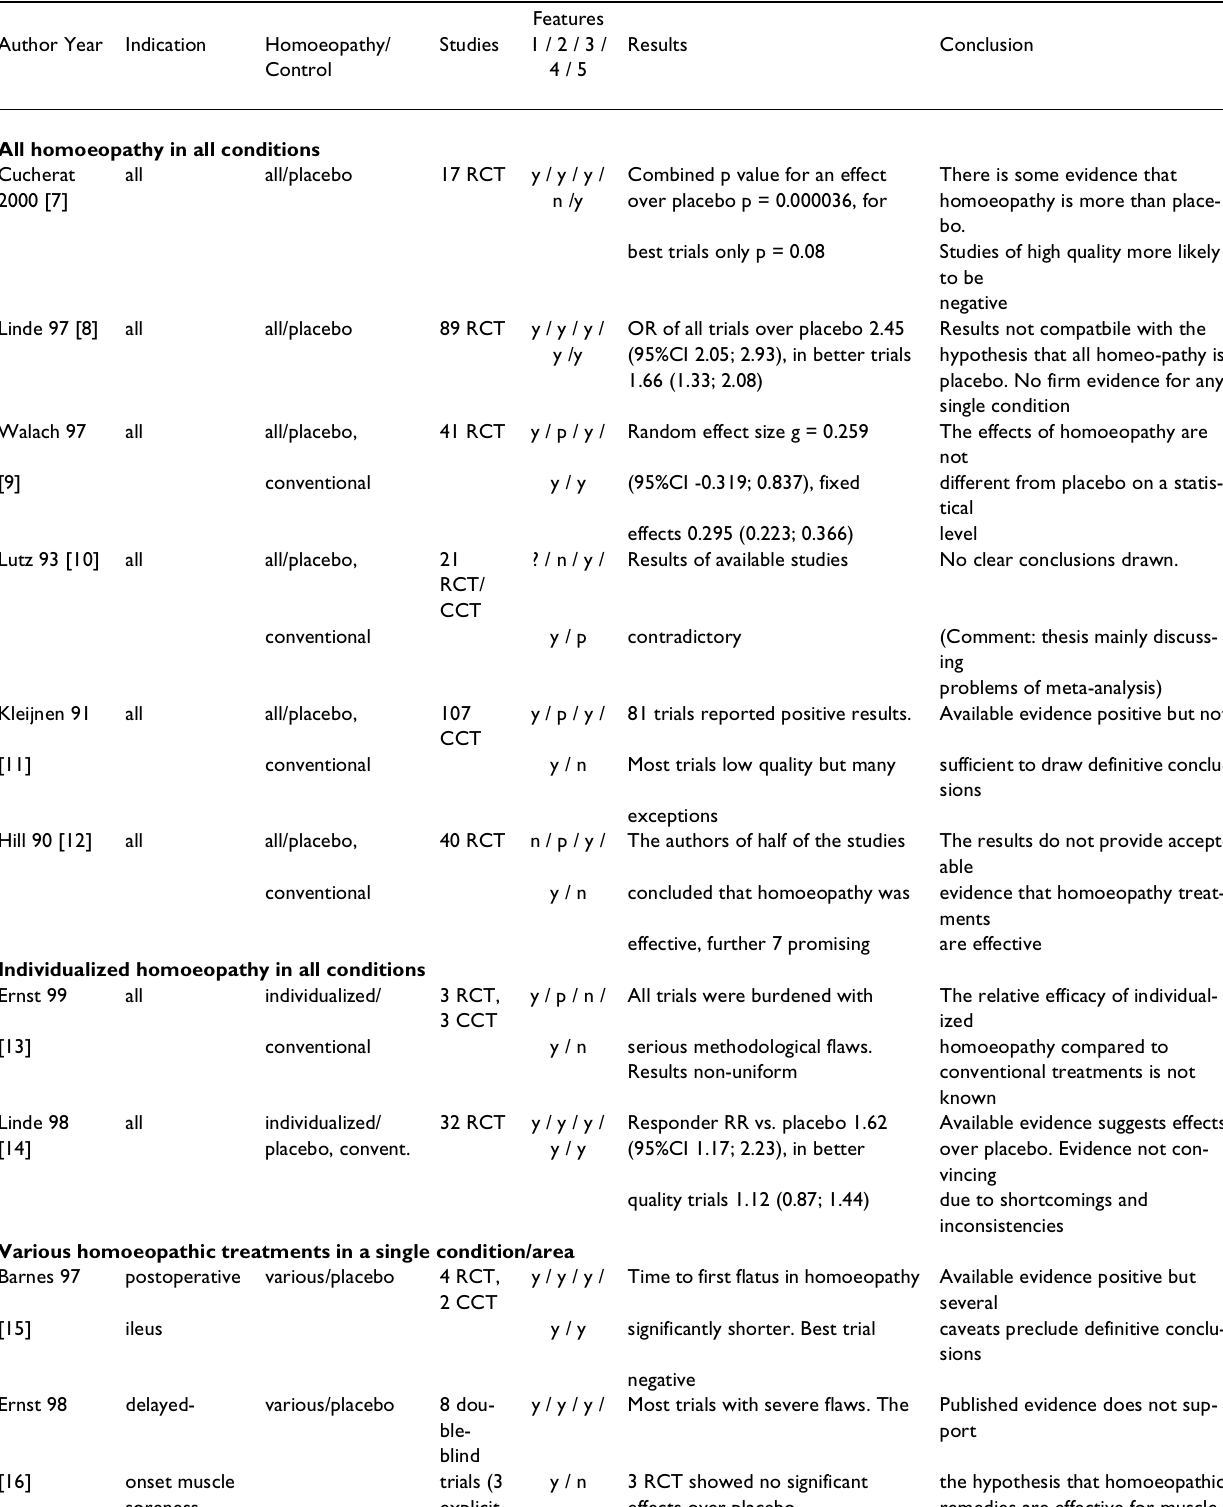
Table 1: Systematic reviews of clinical trials of